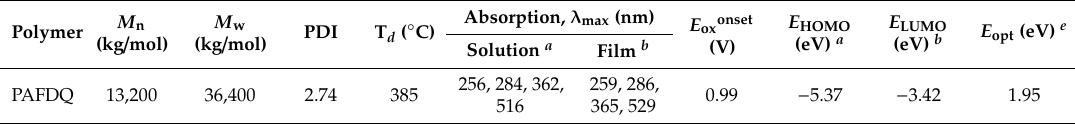
Molecular weight and thermal properties and Optical / electrochemical properties of the